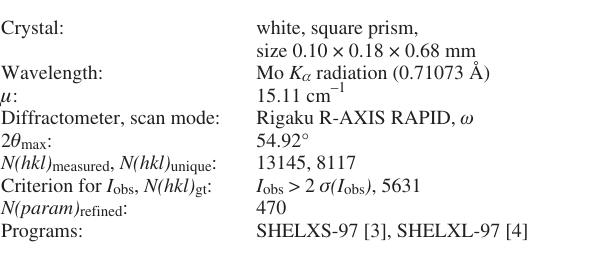
Table 1. Data collection and handling.